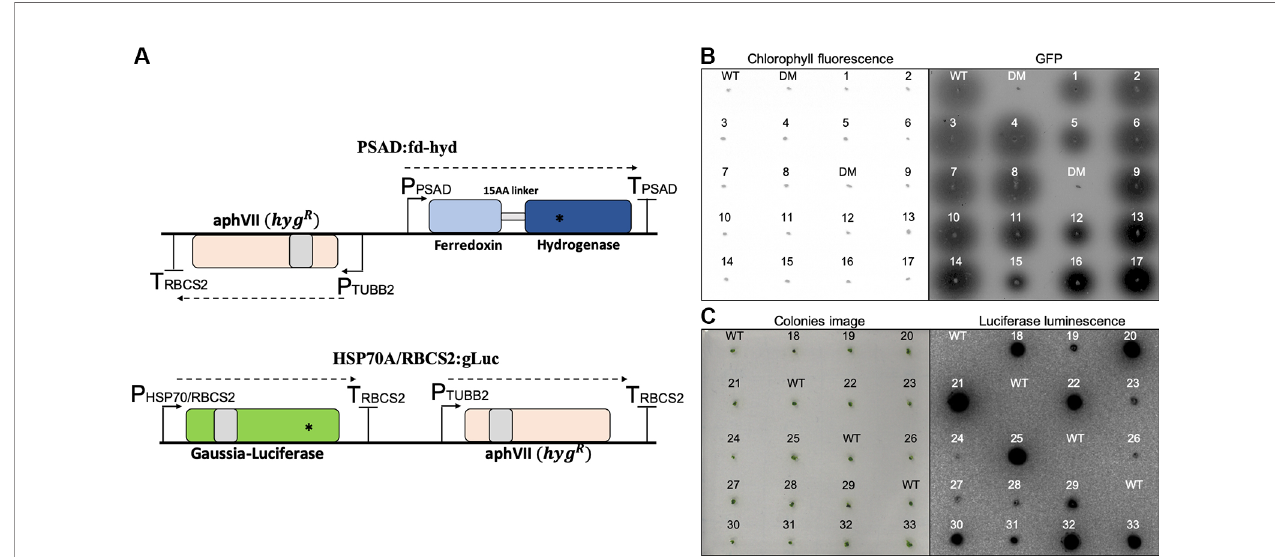
FIGURE 1 | Construction and selection of positive transformants expressing the reporter genes. (A) Plasmid maps of the fd-hyd (upper) and the gLuc (bottom) reporter genes. The fd-hyd transgene was cloned into a modi fi ed pSL18 vector (the paro R was replaced by the hyg R ) under the control of the PSAD regulatory sequences. The gLuc transgene was cloned into pChlamy_1 plasmid ( hyg R ) under the control of the HSP70A/RBCS2 promoters and the RBCS2 terminator. Gray boxes represent the fi rst intron of the RBCS2 within the coding-sequences. Asterisks (*) represent the ddPCR amplicon loci offd-hyd (51bp) and gLuc (85 bp). The cut site of ScaI is found outside the amplicon area (not shown). (B) Rhodobacter assay for selected hydrogen producing colonies. fd-hyd colonies were overlaid with engineered H 2 -sensing R. capsulatus and were scanned using a 473 nm laser for excitation whereas 510 nm or 665 nm fi lters were used for quantifying GFP fl uorescence (right) and chlorophyll density (left), respectively. (C) in-vivo Luciferase assay for the gLuc selected colonies; gLuc colonies were incubated for 10 min in dark, and then 10 m l of 0.01 mM Coelenterazine were dropped onto each colony. The left panels refer to either the detection of the colonies chlorophyll (A) or the photographs of colonies prior to luminescence imaging (B) . The right panels refer to GFP fl uorescence emitted by R. capsulatus (A) or luminescence emitted by gLuc (B) . WT = CC-124 wild-type strain (which naturally produces hydrogen), DM = hyda 1,2 double-mutant strain (does not produce hydrogen). The numbers refer to clone